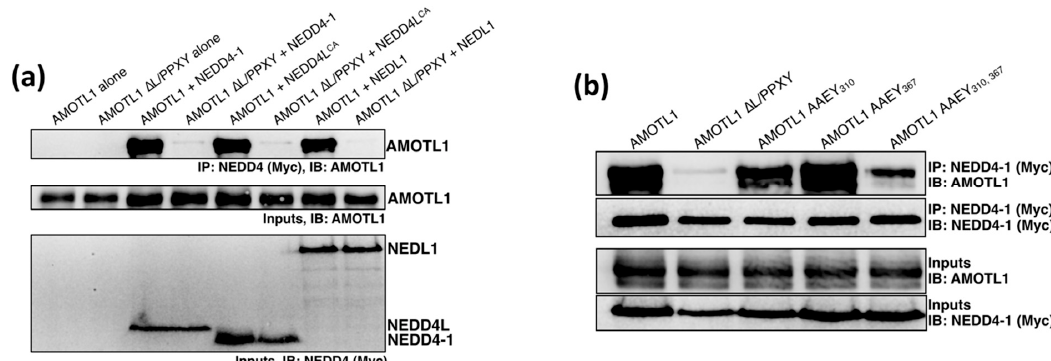
Figure 5. AMOTL1 binds to at least three NEDD4 family members through L/PPXY sequences. ( a ) 293T cells were transfected to produce AMOTL1 or AMOTL1 ∆ L/PPXY together with Myc-tagged NEDD4-1, NEDD4L CA , or NEDL1. Cells were lysed in a solution containing 0.5% NP-40, and immunoprecipitation was carried out using Myc antibody. Proteins were fractionated on SDS gels and detected by immunoblotting using anti-AMOTL1 or anti-Myc antibodies, as indicated. ( b ) 293T cells were transfected to produce Myc-tagged NEDD4-1 together with the indicated AMOTL1 mutants having altered PPEY and/or LPTY sequences. Cells were lysed and co-immunoprecipitation analysis was carried out as described for panel ( a ).